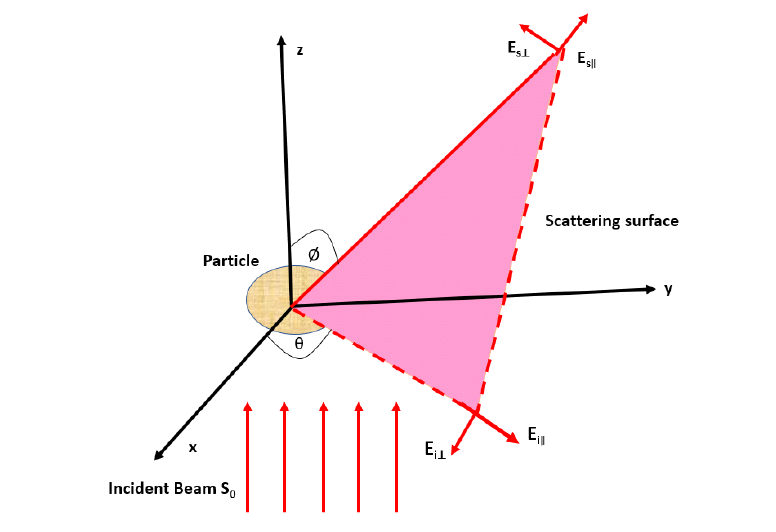
Figure 6. Geometry represents the scattering of light by an object located at the